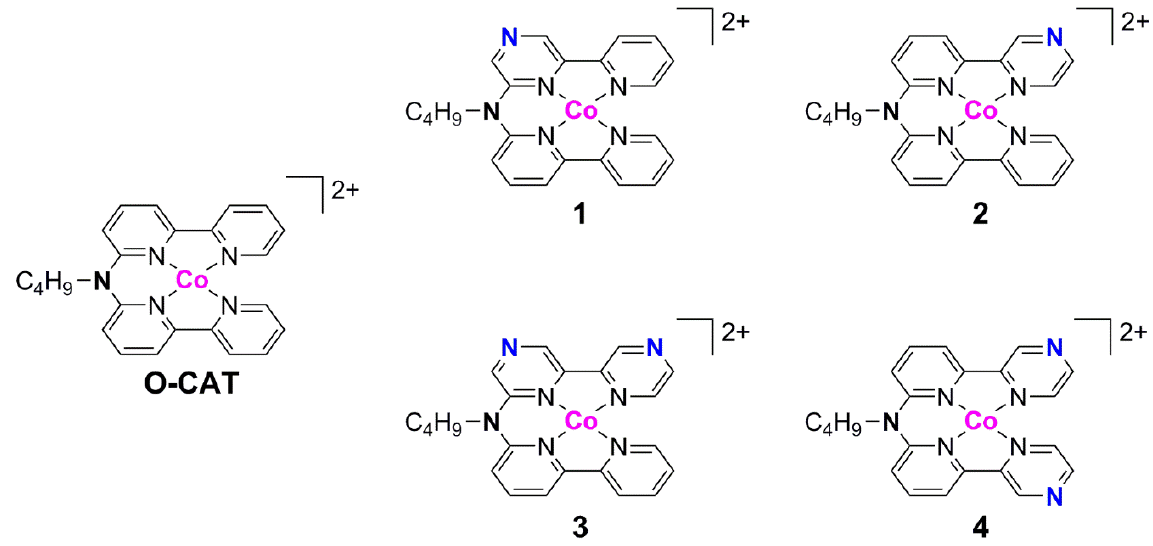
Figure 1. Chemical structures of parent Co(II)tetra(pyridyl) molecular catalyst with amine-bridged 2,2′-bipyridine groups ( O-CAT ), and its pyrazine-functionalized derivatives 1 – 4 .